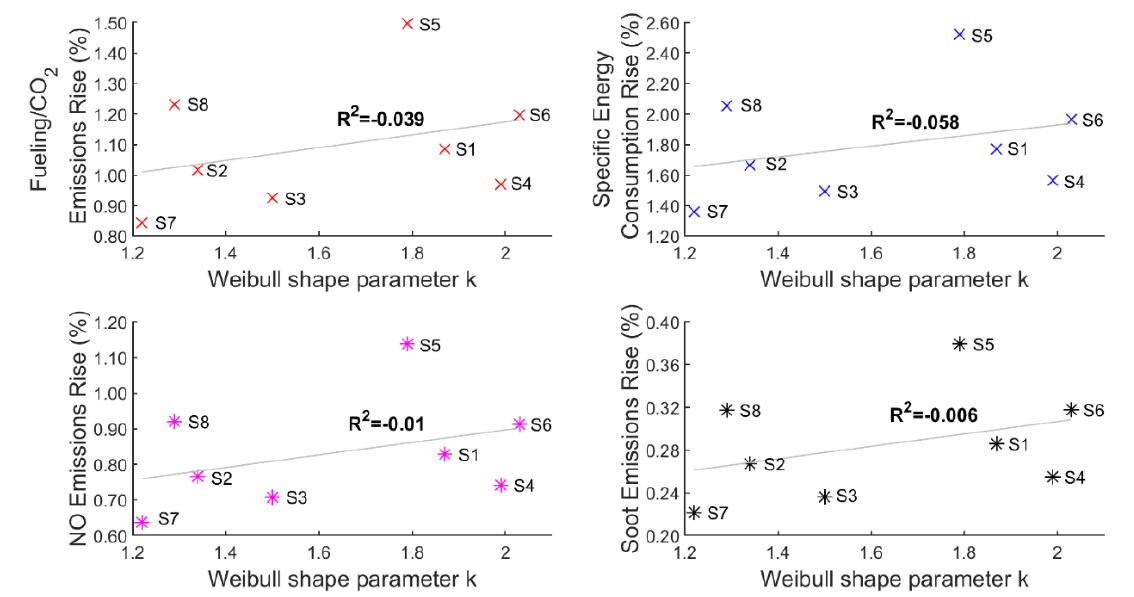
Figure 6. Expected rise in fuel/energy consumption and emissions vs. Weibull shape parameter k.